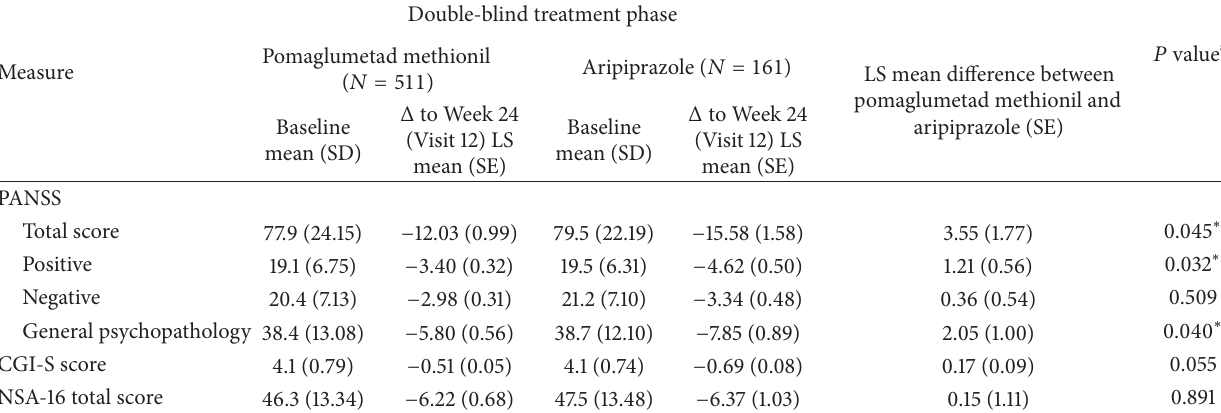
𝑃 value a Pomaglumetad methionil